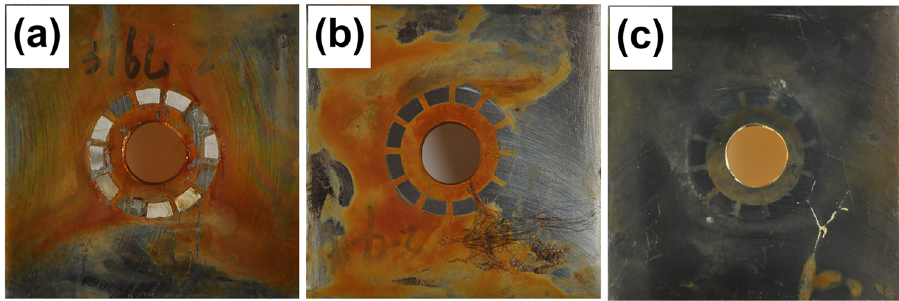
Fig. 8 Macroscopic corrosion morphologies of three stainless steels covered with nylon meshes after immersing in natural seawater for 24 months. a 316L SS, b 2205 DSS, c 2507